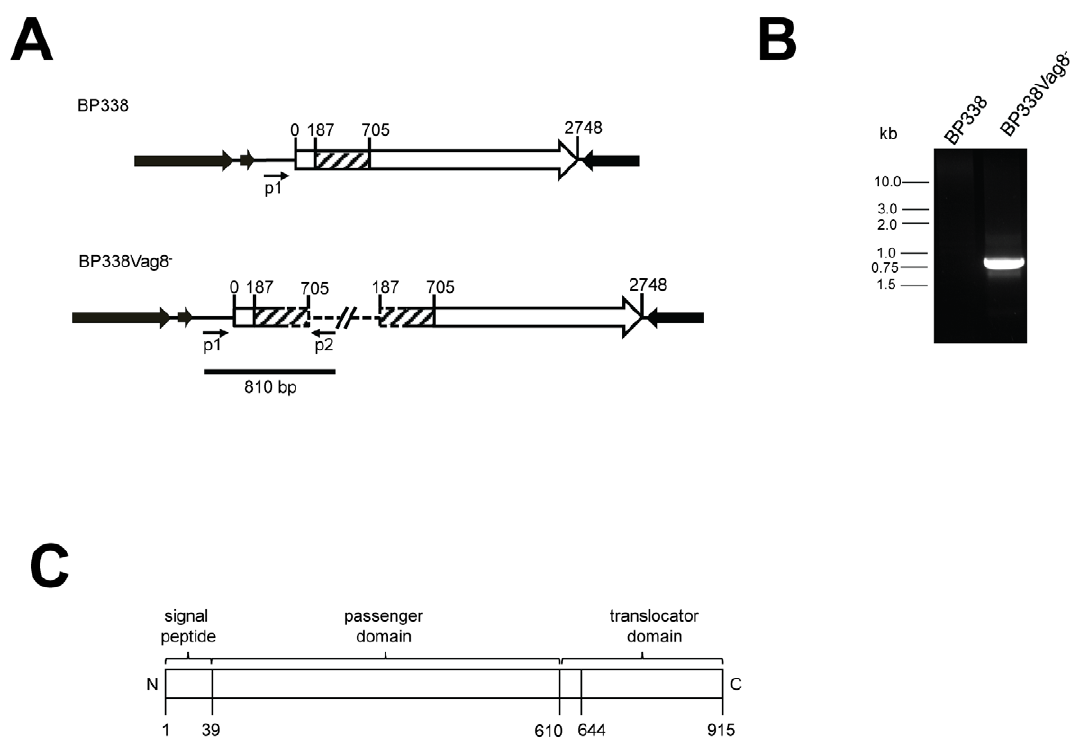
Figure 2. Generation of vag8 mutants and description of the vag8 genetic locus and predicted protein architecture. A Schematic of the vag8 locus that is knocked out in B. pertussis mutant BP338Vag8 2 . The 2748-bp coding sequence of vag8 is shown as an open arrow, with the hatched region indicating the internal vag8 fragment which was cloned into vector pEG7 to generate vector pEG7-Vag8. Dashed lines indicate vector sequence in the mutant strain. Solid lines indicate genomic sequence of BP338. vag8 is flanked by rRNA genes at the 5 9 end and locus tag BP2314 at the 3 9 end (solid arrows, not drawn to scale). The bar indicates the 810-bp PCR product (shown in B ) that was indicative of the correct genomic integration of pEG7-Vag8 into the vag8 gene. C Architecture of the 95-kDaVag8 autotransporter protein. The predicted signal peptide and the passenger and translocator domains are indicated. The region spanning residues 610 and 644 comprise a predicted alpha-helical linker region present in all autotransporter proteins. Unlike many autotransporter proteins, Vag8 is not cleaved to separate its passenger domain from the translocator. The duplicated fragments of vag8 in BP338Vag8 2 are missing sequences encoding the translocator and signal peptide respectively.